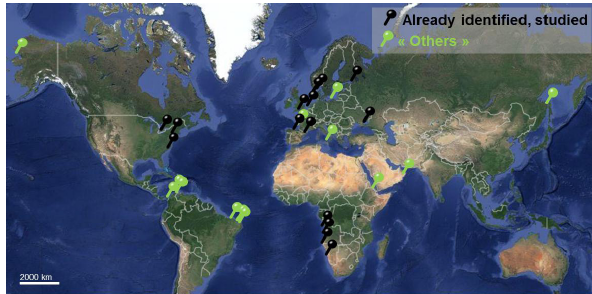
Fig. 1. Map of identified kilometric shoreline sandwave sites. Back- ground image: Google